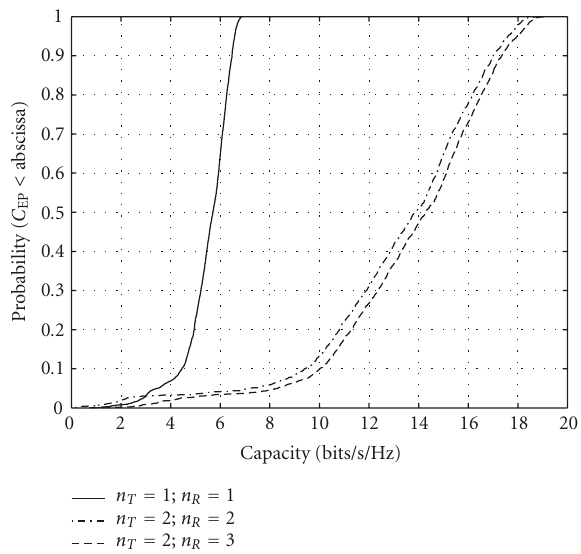
Figure 8: CDF of the equal-power capacity (Scenario 1).